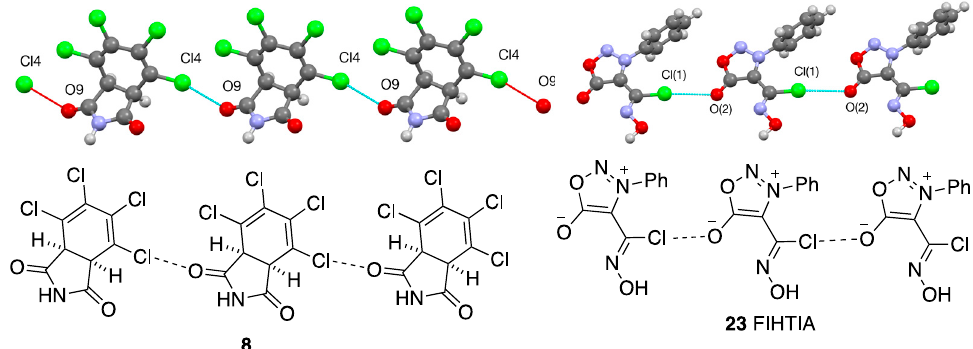
Figure 8. Halogen bonding interaction in structure of 8 [C–Cl . . . O parameters: C(4)–Cl(4) 1.722(2), Cl(4) . . . O(9) 2.940(1), C(4)–O(9) 4.569(2) Å, angle 156.26(6) ◦ ] and for comparison 23 [C–Cl . . . O parameters: C(9)–Cl(1) 1.717(2), Cl(1) . . . O(2) 3.150(2), C(9)–O(2) 4.861(3) Å, angle 173.57(9) ◦ ].